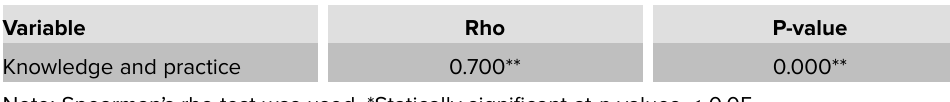
TABLE 5: Correlation between knowledge and practice of the study